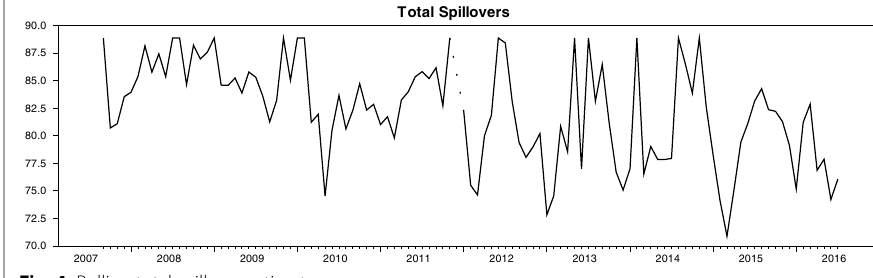
Fig. 4 Rolling total spillover